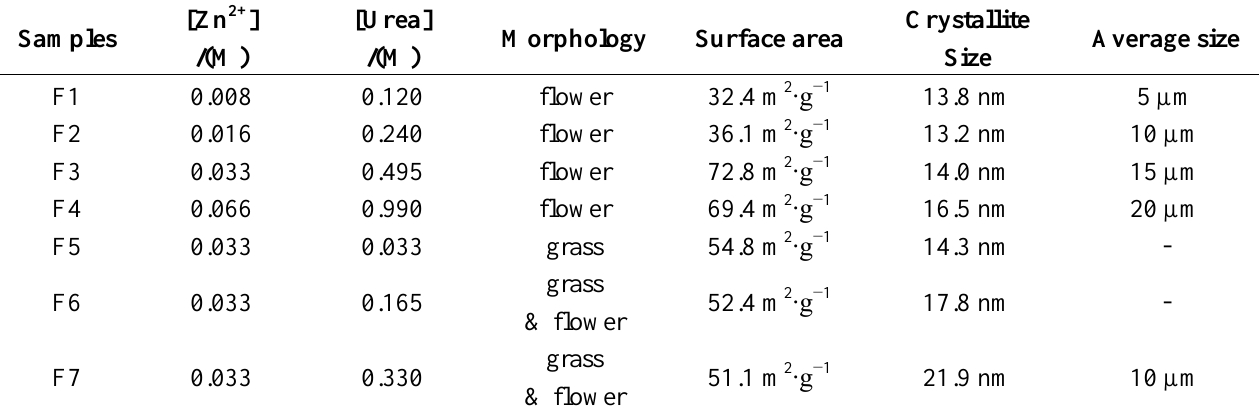
Table 1. Reaction conditions for the preparation of ZnO porous structures and their morphologies. Samples